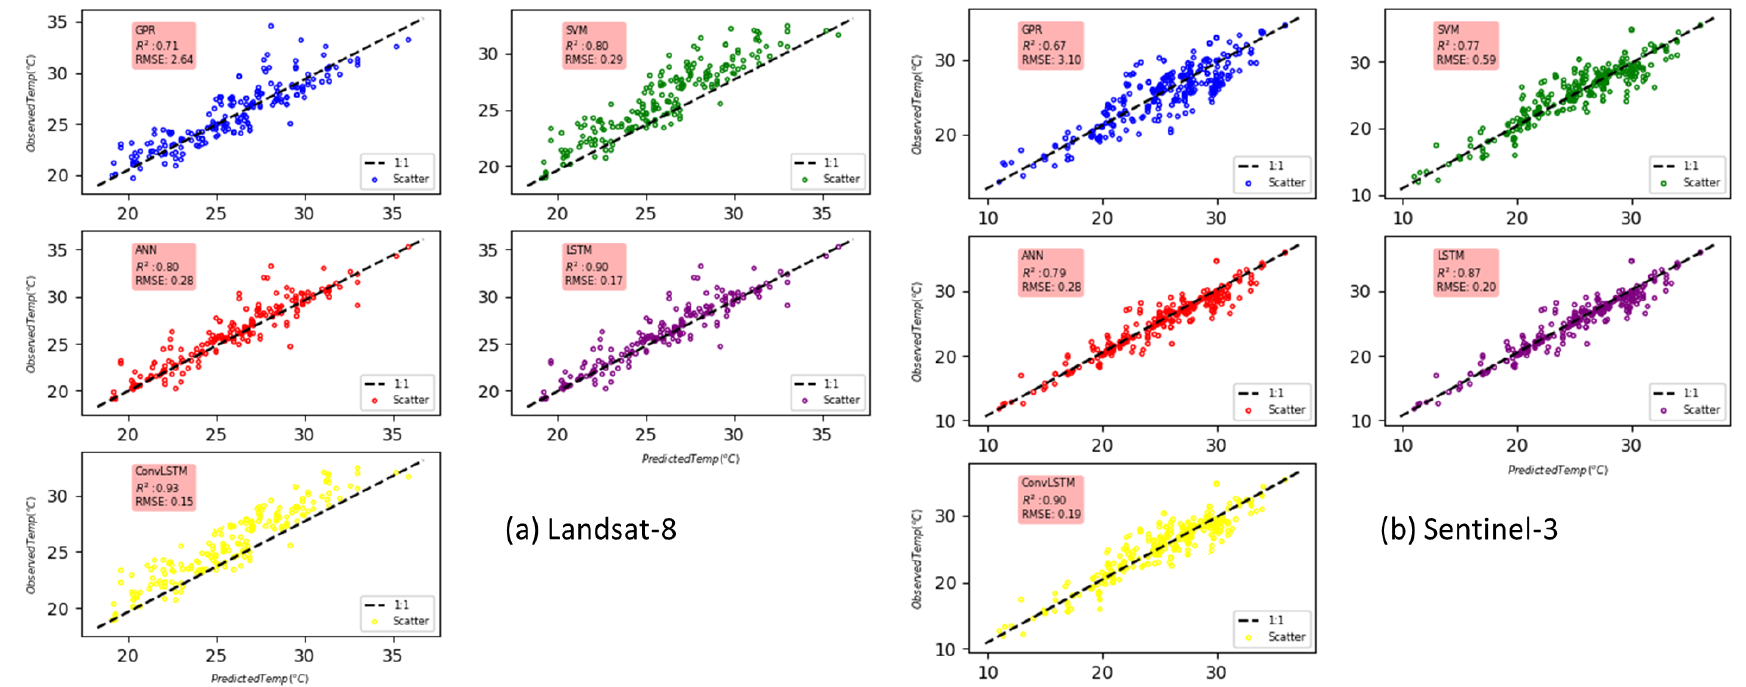
Figure 9. Observed vs. predicted WST regression scattergrams derived from the ML/DL models test data. The name of the ML/DL, R 2 and RMSE are shown in the graph legends. The distribution of the scatter point markers along the line of equality (1:1) are also visualized in the figure; ( a ) Landsat-8 models are in the left and middle left columns, and ( b ) Sentinel-3 models are in the middle right and right columns.